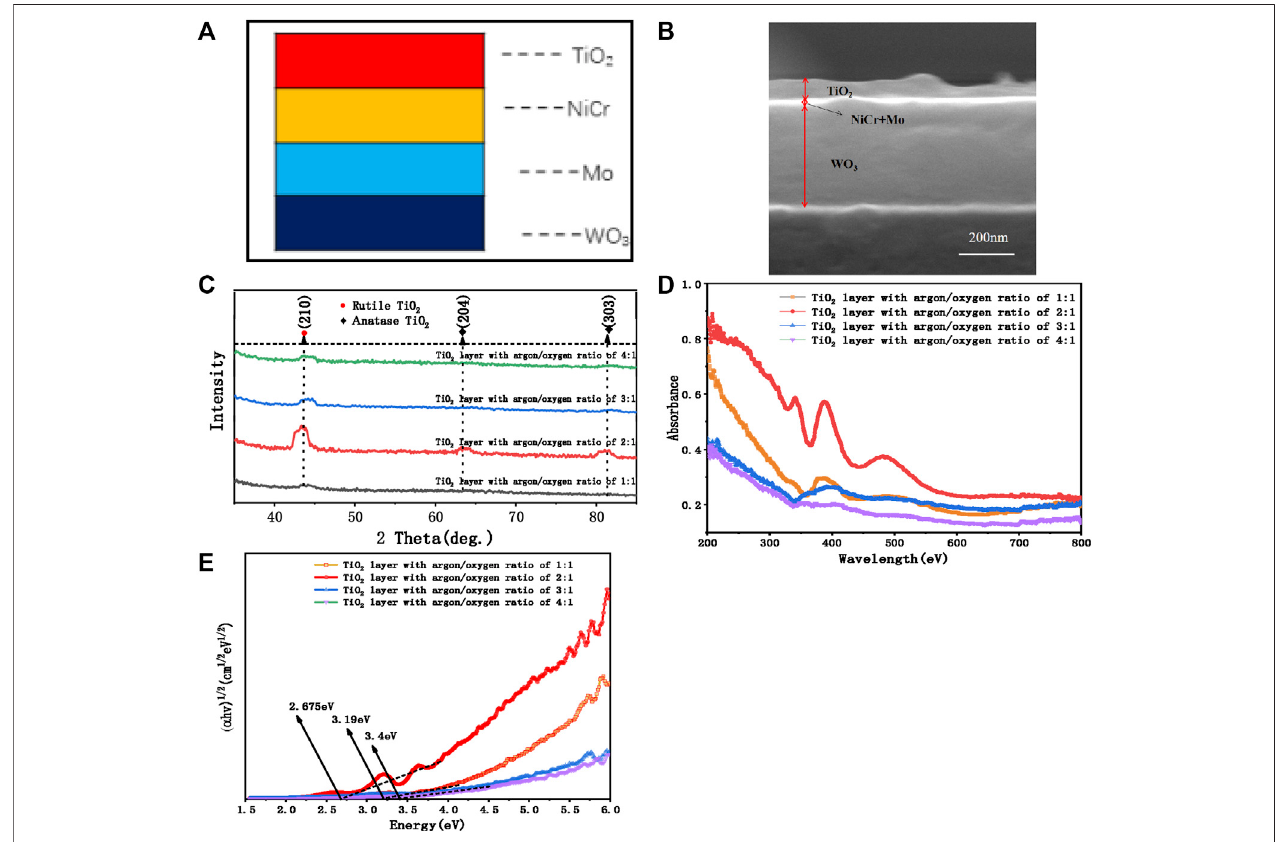
FIGURE 1 | (A) Multifunctional membrane layer structure, (B) FESEM image of a membrane layer structure, (C) XRD patterns, (D) absorption spectra, and (E) Tanc ’ s plot for multifunctional membrane of TiO 2 layer with different argon oxygen ratios.